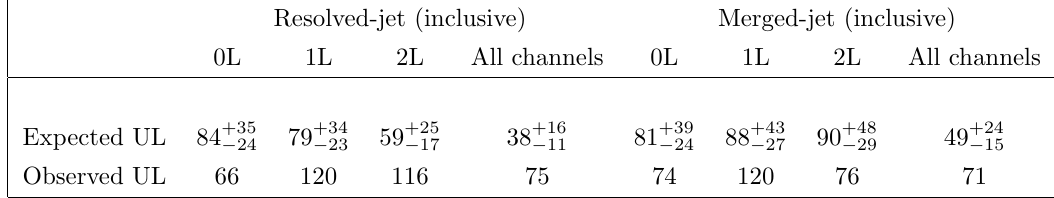
Table 5 . Observed and expected UL at 95% CL on the signal strength (cid:22) for the VH(H ! cc) production for the resolved-jet and merged-jet topology analyses, which have a signi(cid:12)cant overlap. The results are also shown separately for each analysis